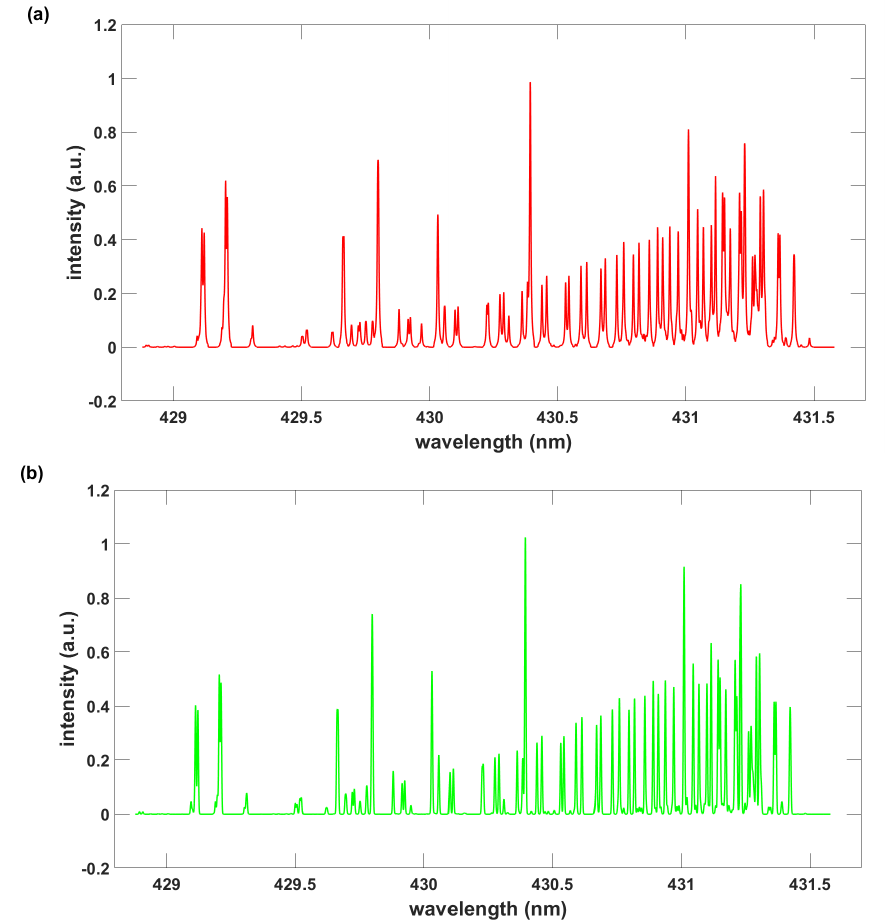
Figure 3. Comparison of measured ( a ) and fitted ( b ) CH A − X spectra, δ λ = 0.005nm, T = 1.47